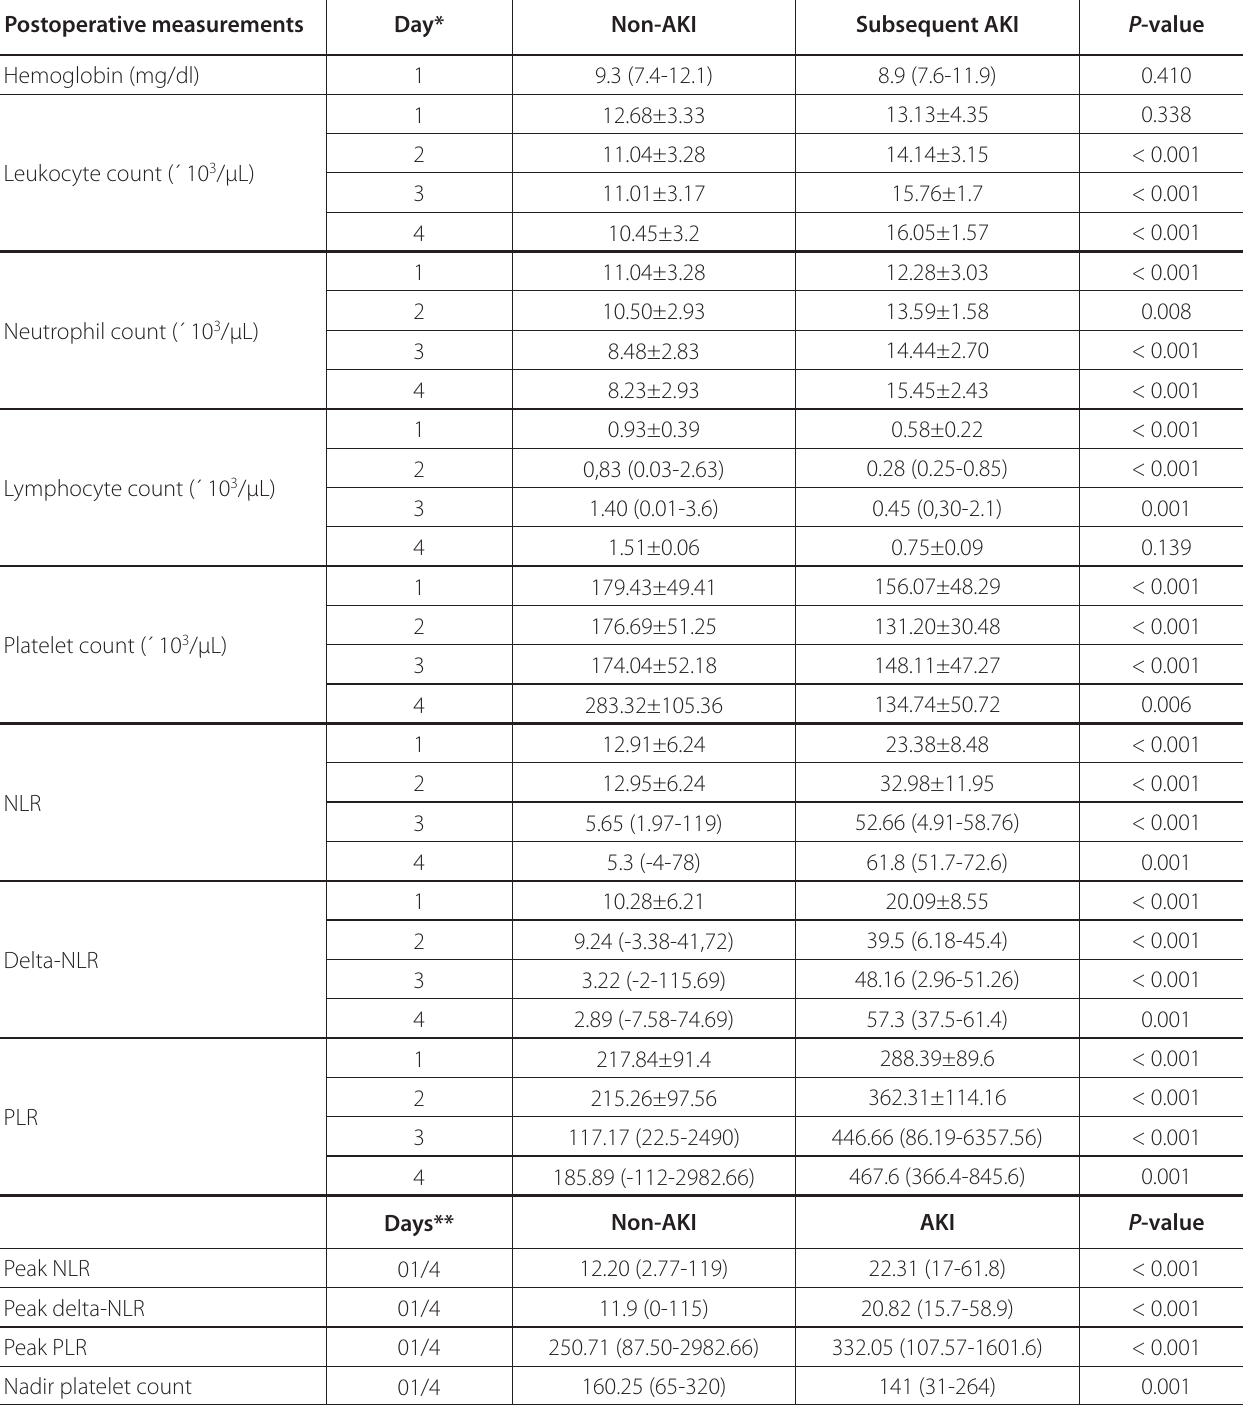
Table 2 . Hematological parameters for the prediction of AKI for each postoperative